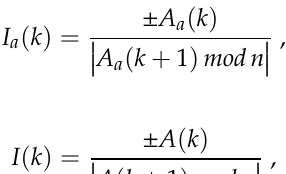
Figure 17. Definition of the parameters in feature vector F; d i is the corresponding length of triangle, α i is the corresponding angle and A is the area of triangle.